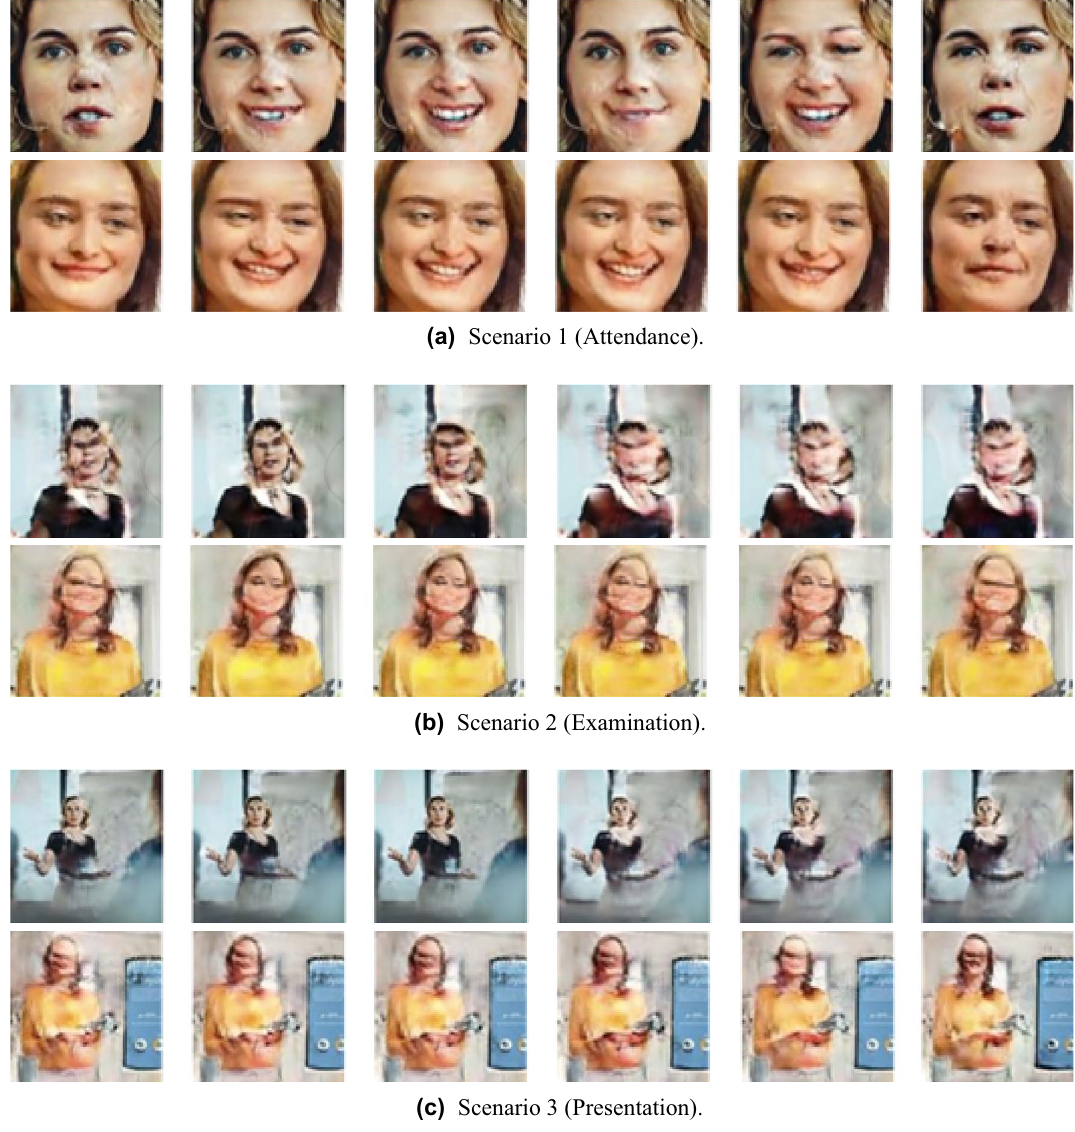
Figure 7. Sample frames of generated videos using the GANimation.